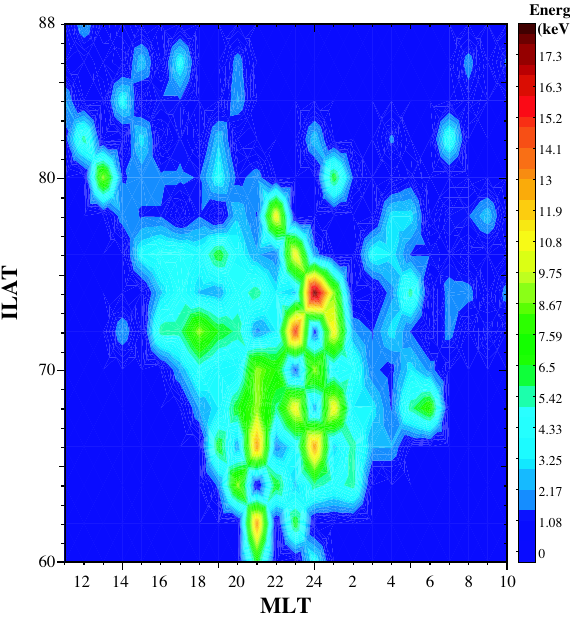
Fig. 5. The distribution of the peak energy (colour-coding) as a function of ILAT and Magnetic Local Time (MLT). Typical invari- ant latitudes for inverted-V observations are 65–75 ◦ . Highest peak energies are usually observed around the magnetic midnight as well as at lower latitudes.